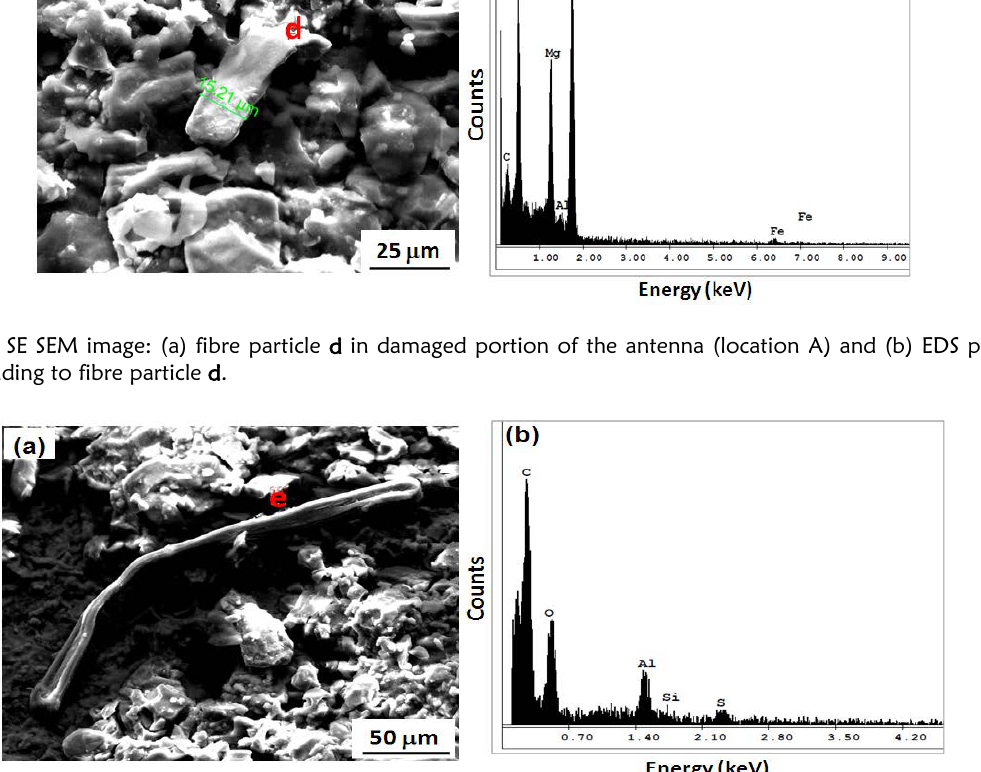
Figure 12: SE SEM image: (a) fibre particle e in damaged portion of the antenna (location A) and (b) EDS pattern corresponding to fibre particle e.